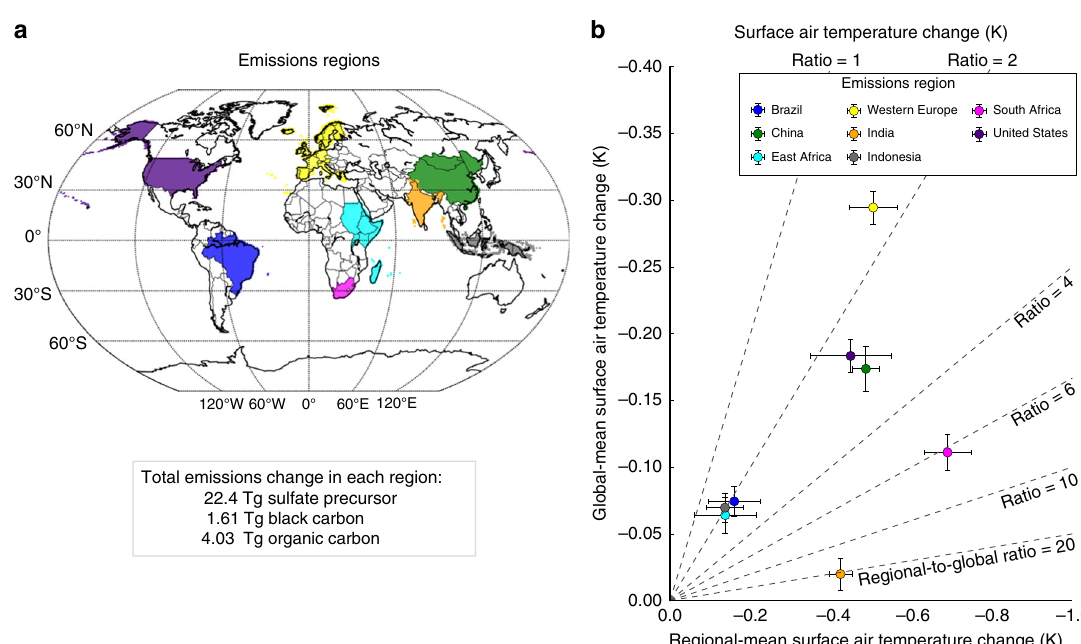
Fig. 1 Global and regional-mean temperature responses to identical aerosol emissions in different regions. Identical total annual emissions of sulfate and black carbon aerosol from eight major past, present, and potential future emitting regions ( a ) result in global-mean cooling spanning a 14x range ( b , y -axis), differing substantially in the degree to which that cooling is felt in the emitting region ( b , x -axis). Diagonal lines ( b ) indicate the ratio of regional- to global- mean cooling. Error bars in b capture the standard